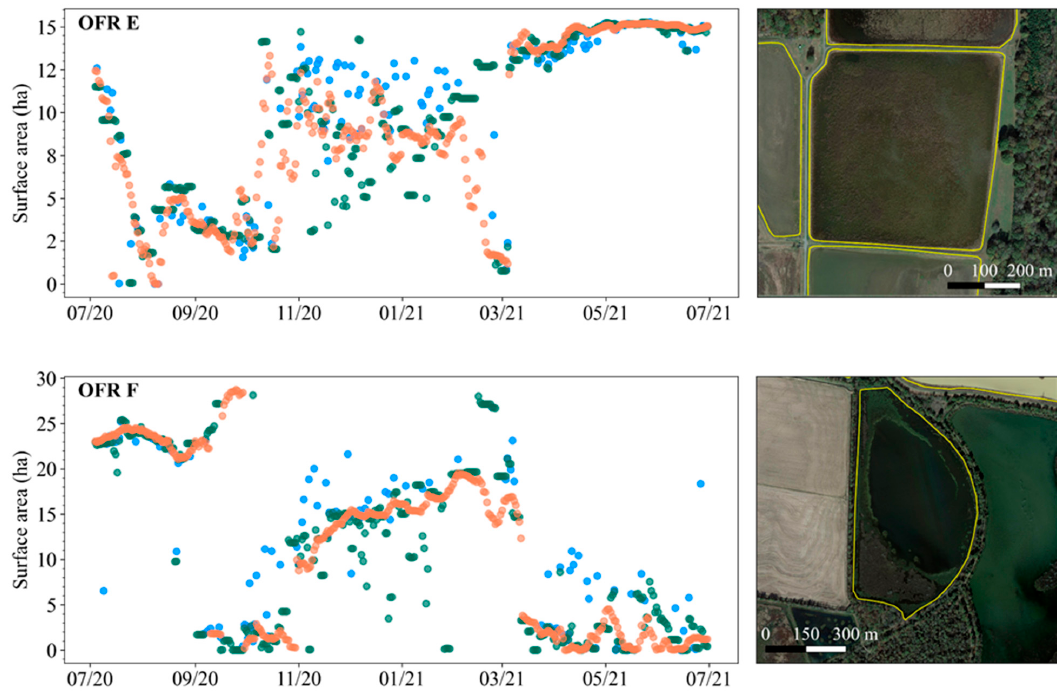
Remote Sens. 2021 , 13 , x FOR PEER REVIEW 16 of 21 Figure 8. OFRs (see Table 2) surface-area time series derived from PlanetScope, Basemap, and Planet Fusion and OFR shapefiles overlaid on high-resolution Google Satellite imagery.